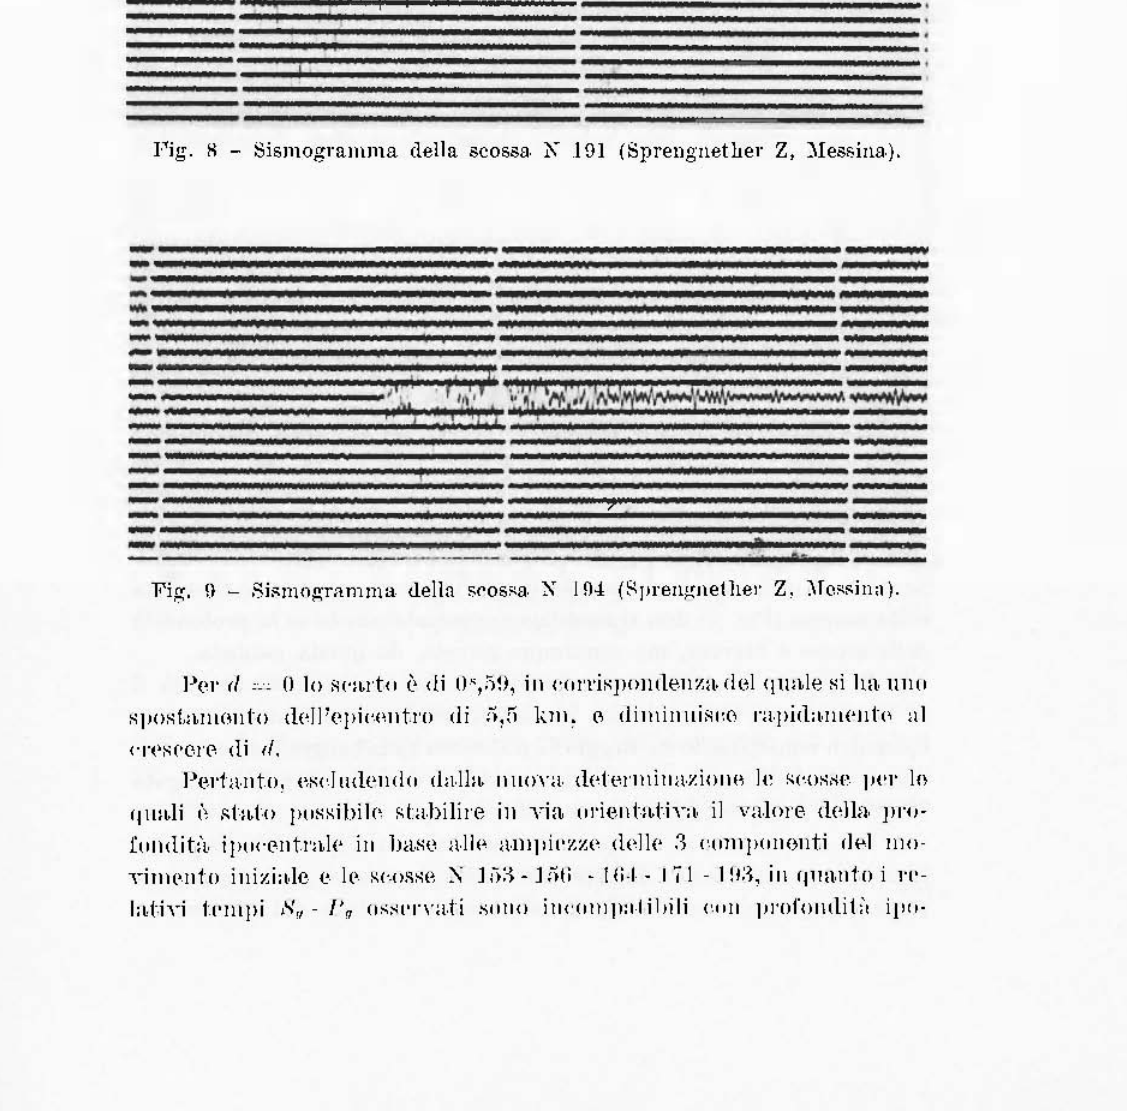
l'ig. H - SiSlllogralllllla della scossa X Hll (Sprengnether Z, ::\lessina),